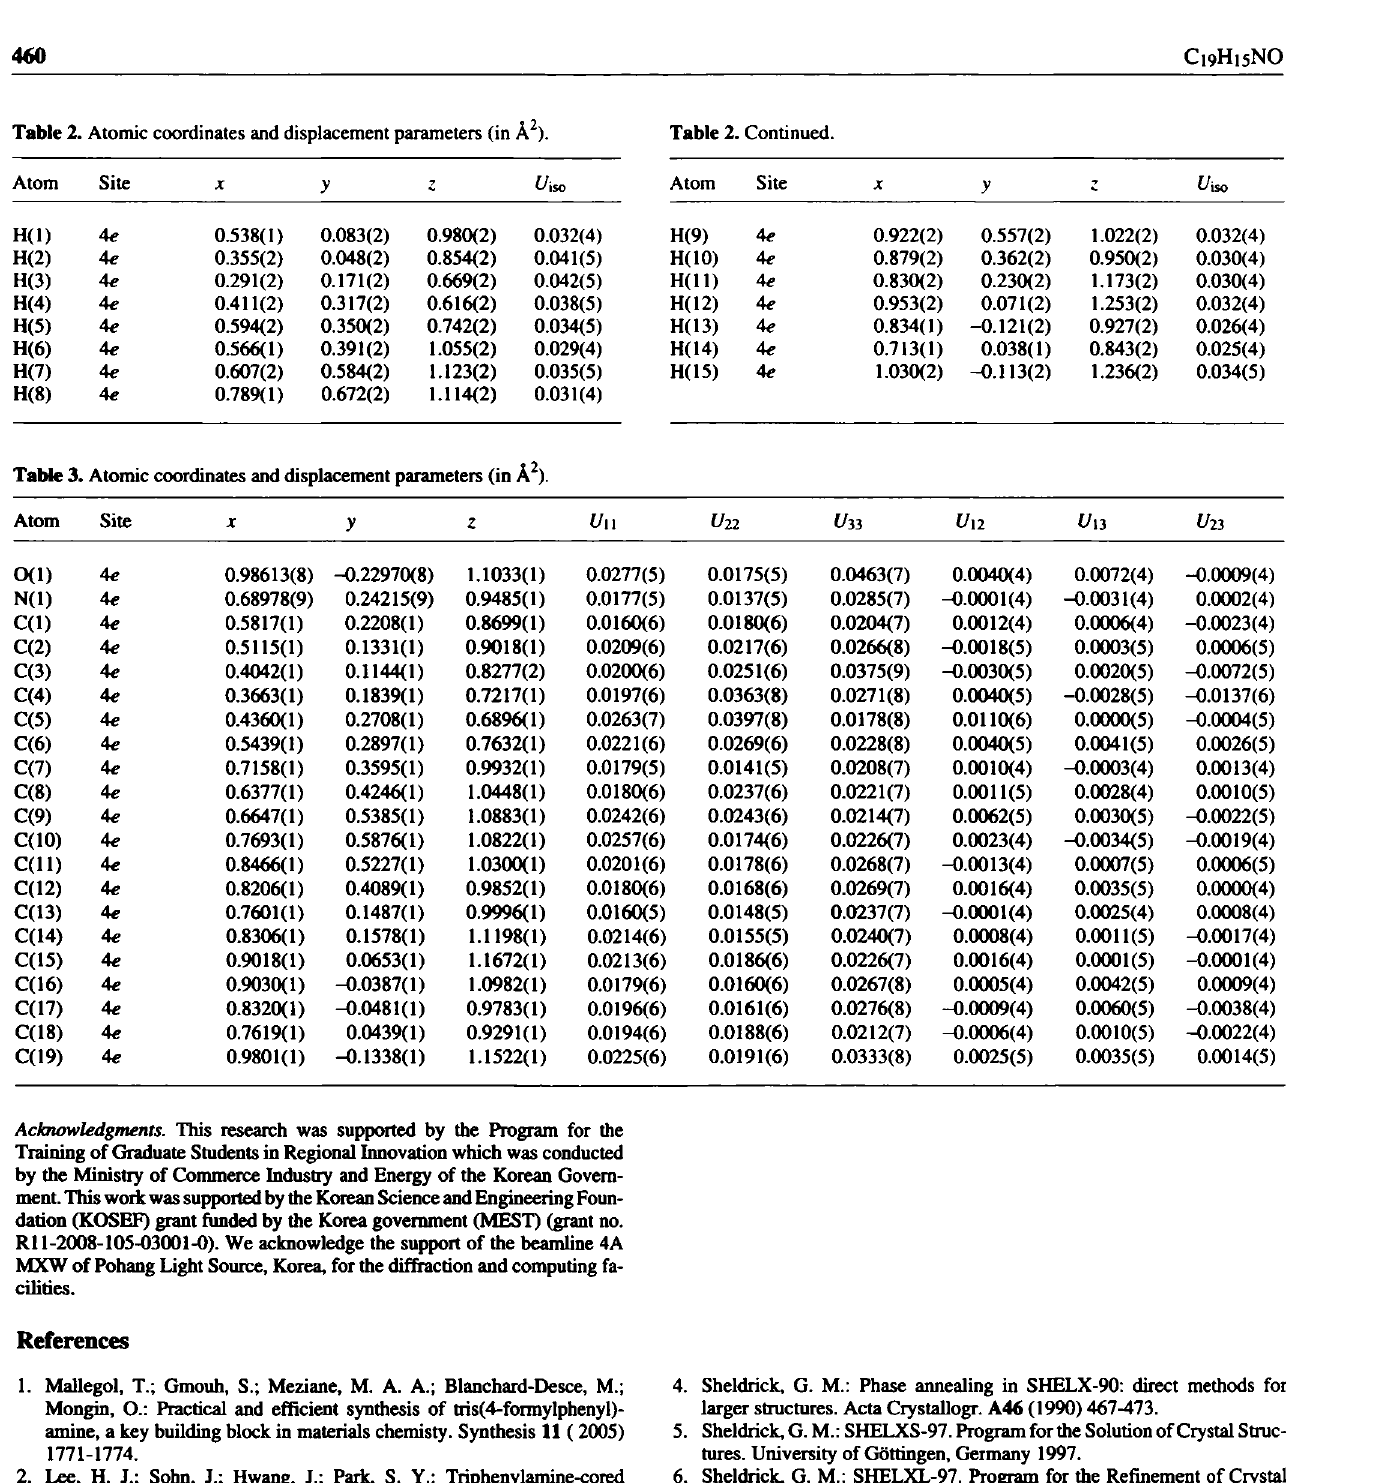
Table 2. Atomic coordinates and displacement parameters (in Â 2 ).